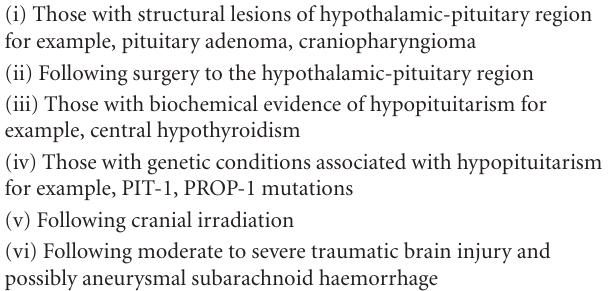
Table 1: Adult patients in whom testing for GHD can be consid-